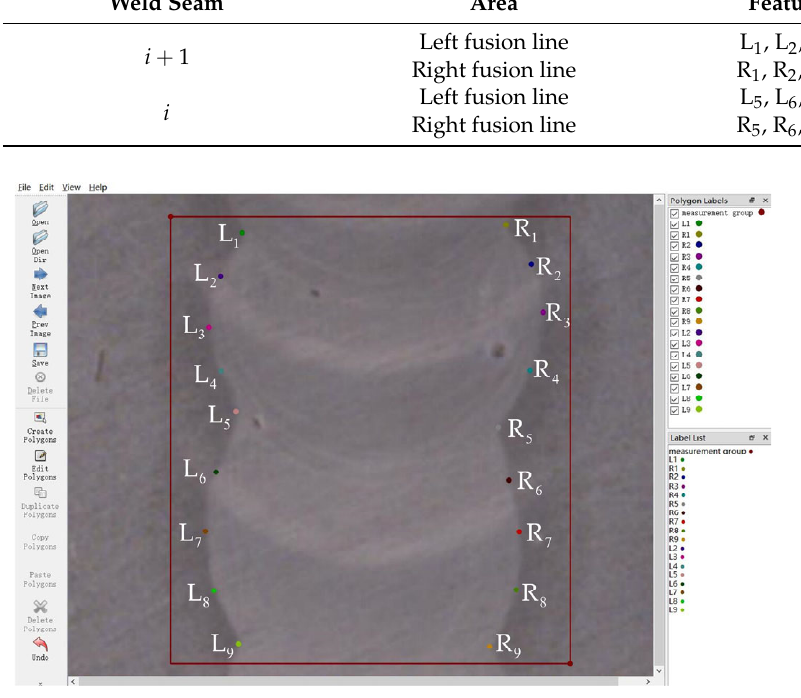
Figure 5. “Measurement unit” key point labeling diagram.